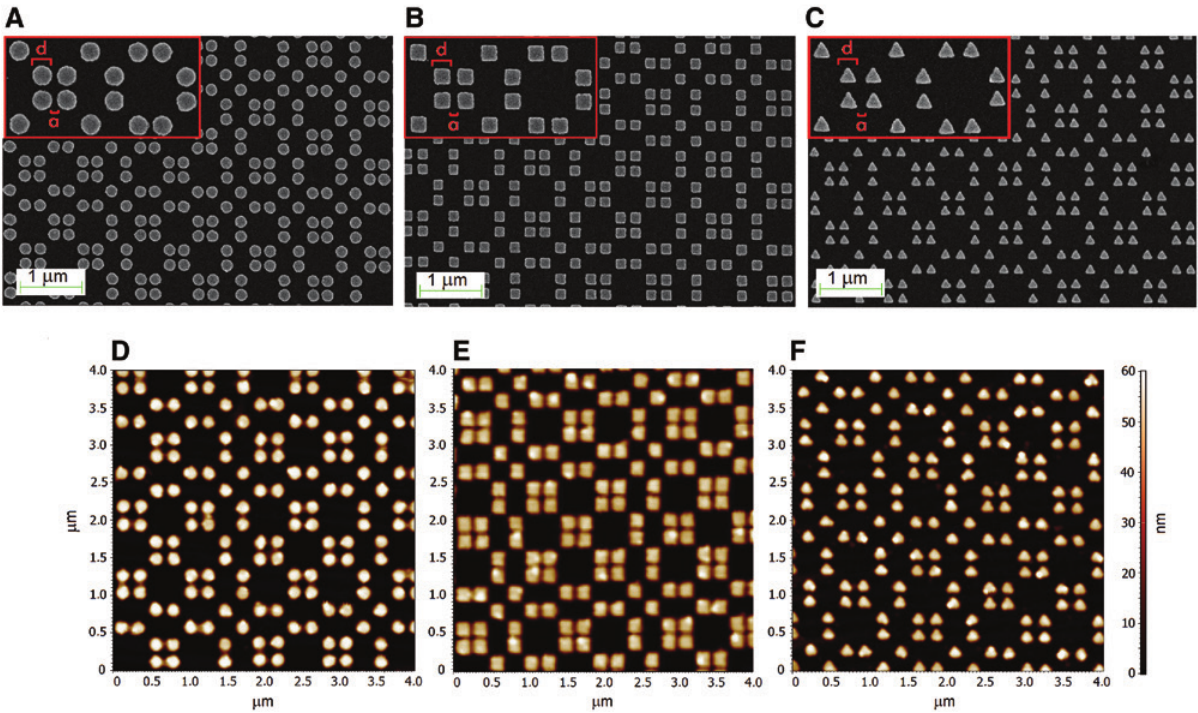
Figure 1: SEM images of ThMo nanopatterns with d = 180 nm, a = 50 nm and circular (A), square (B), and triangular (C) NPs. AFM images of ThMo nanopatterns with d = 180, a = 50 nm and circular (D), square (E), and triangular (F)